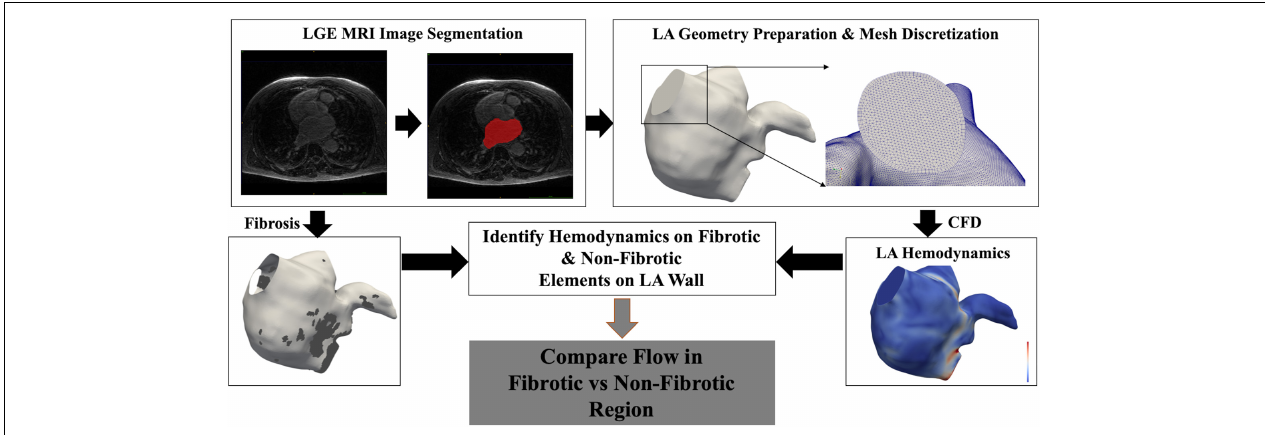
FIGURE 1 | Workflow of the personalized computational fluid dynamic (CFD) simulation and comparison of hemodynamics between fibrotic and non-fibrotic regions for each case. Bottom left panel shows the left atrial (LA) model with fibrotic region highlighted in dark gray, and bottom right panel shows contour of wall shear stress (WSS) magnitude.